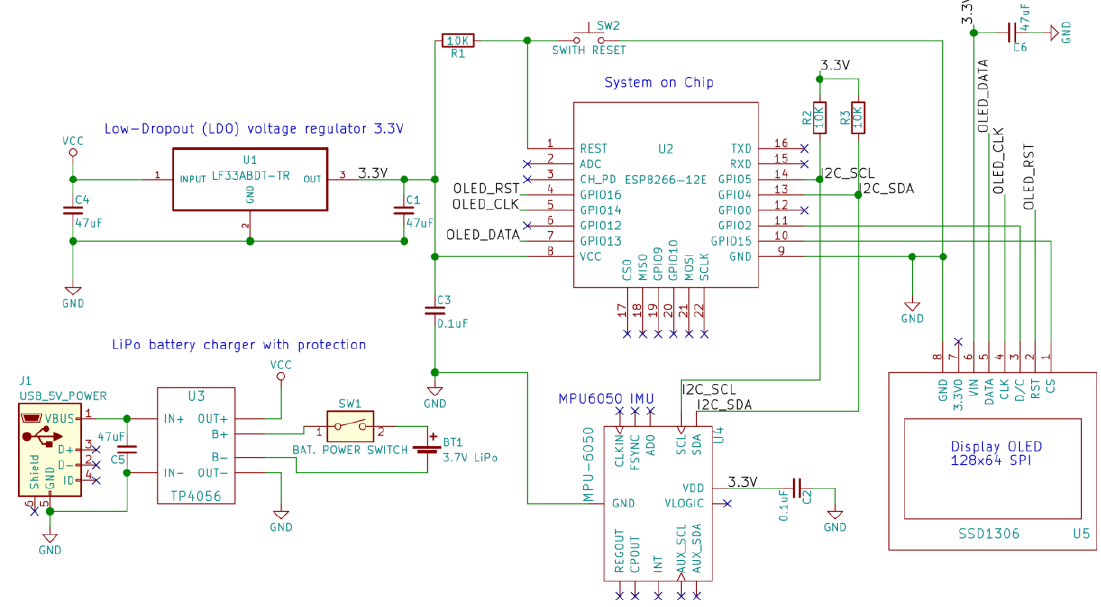
Figure A1. Hardware scheme of the smart device for healthy eating behaviors.